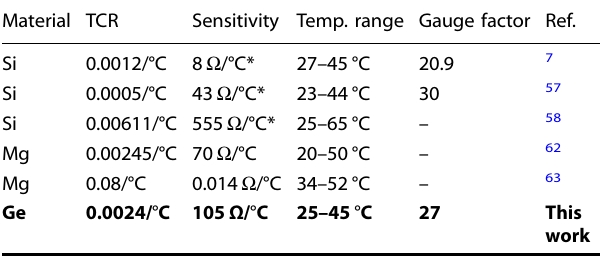
*Represents the data calculated from the reference. Bold values represent our